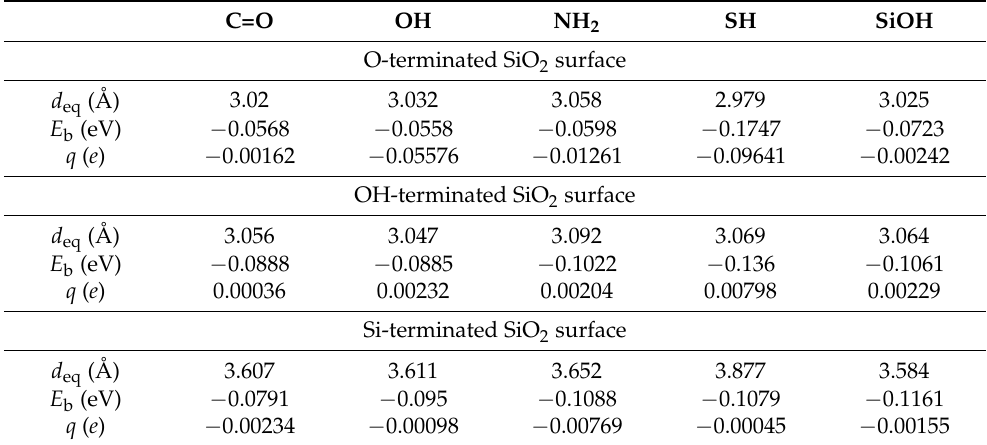
Table 1. The interfacial distances d eq , adhesion energy E b , and charge transfer q of molecules Gly, Cys, and DMS contacted with SiO 2 slab, respectively. Positive (negative) q represents that charge transfers from SiO 2 (molecule) to molecule (SiO 2 ) surface.